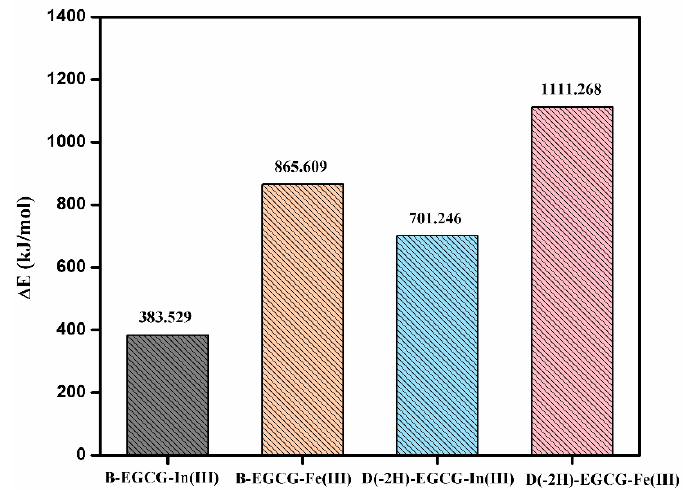
Figure 5. The binding energy of EGCG–metal complexes.